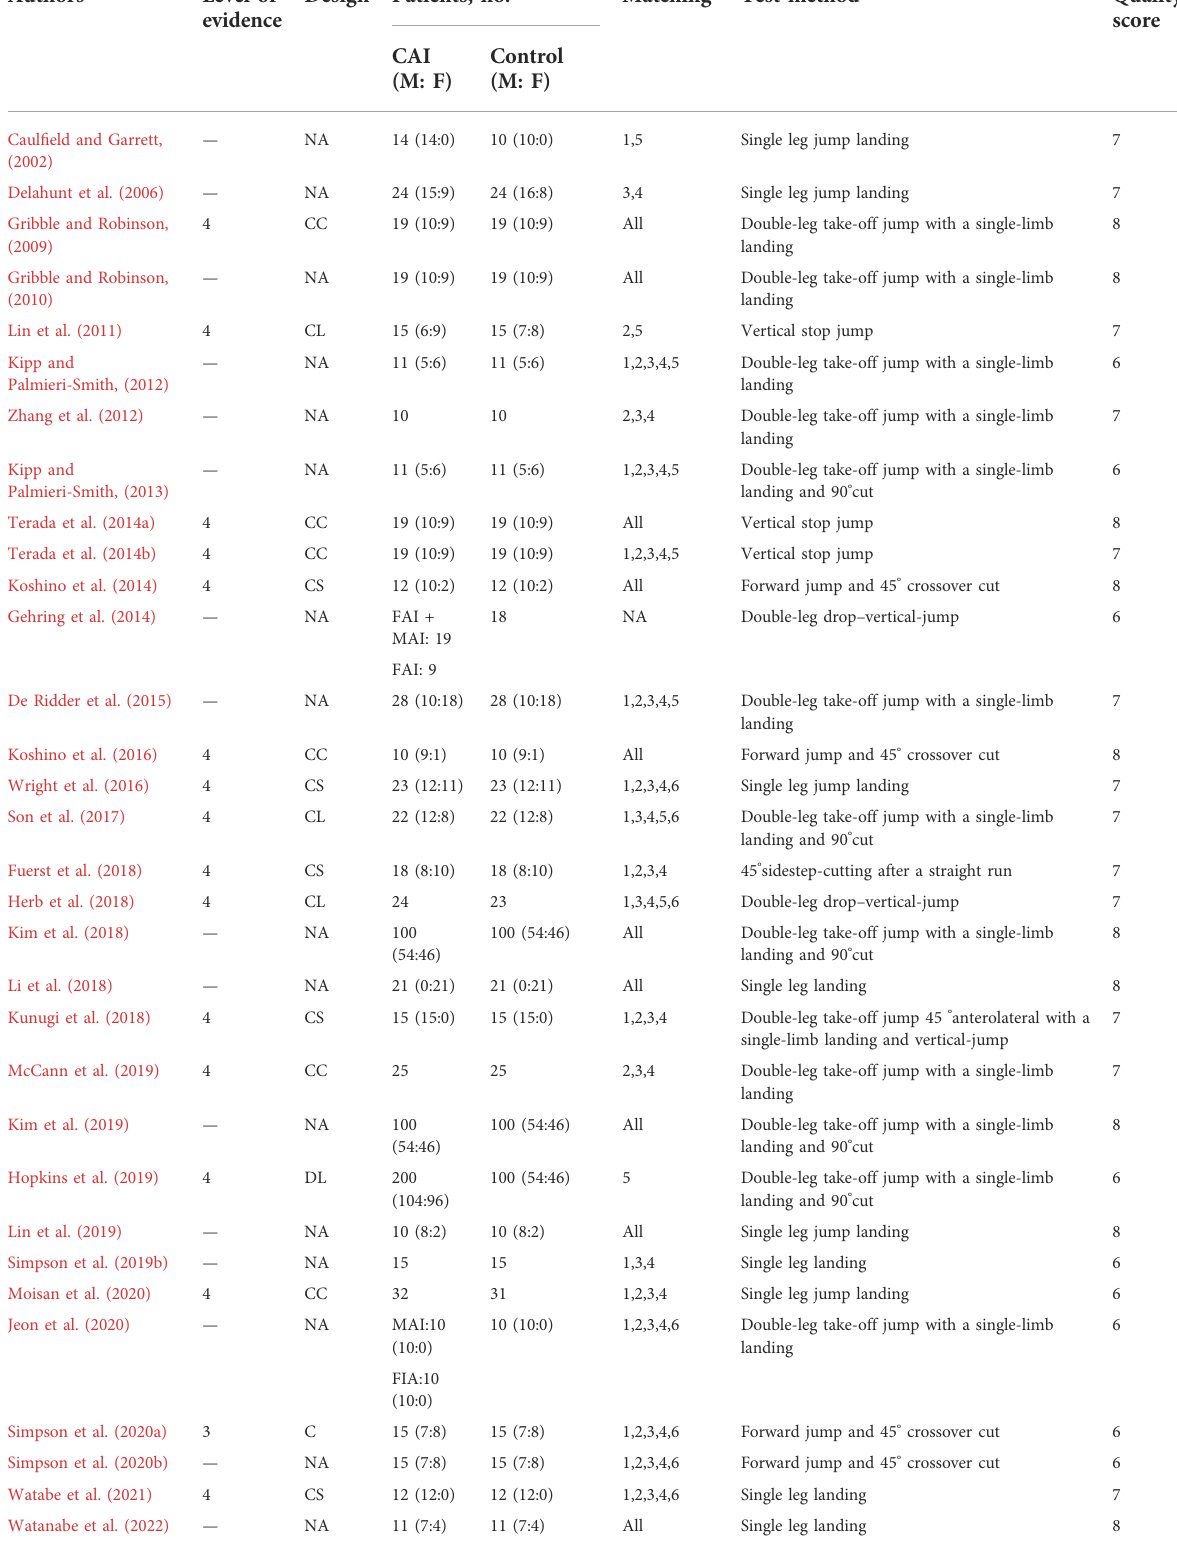
TABLE 1 Basic characteristics of the included